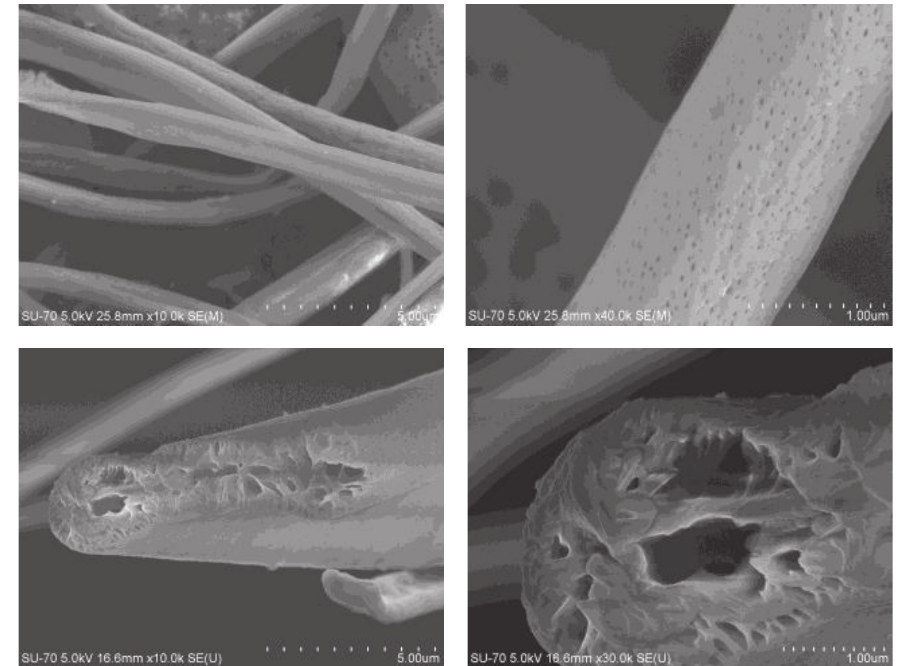
Figure 5: Scanning electron micrographs of polymer 2 a